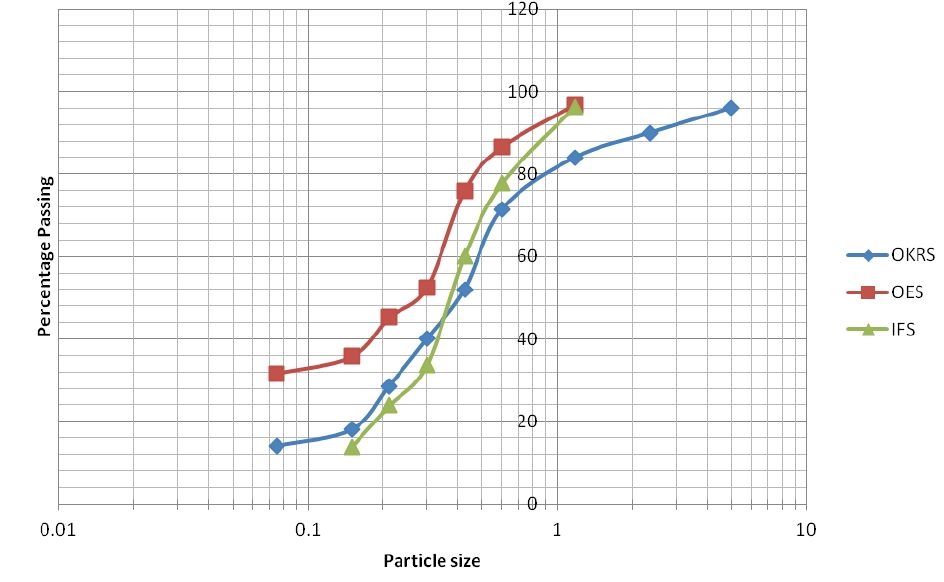
Figure 3. Grading curves for OKRS, OES and IFS on a semi-logarithmic plot.